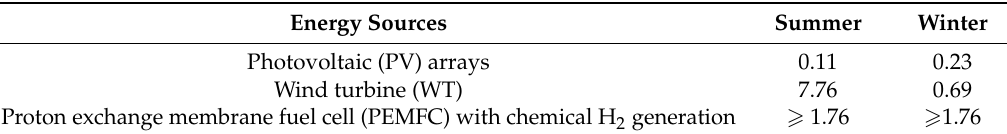
Table 2. Energy cost analyses ($/kWh) [32].